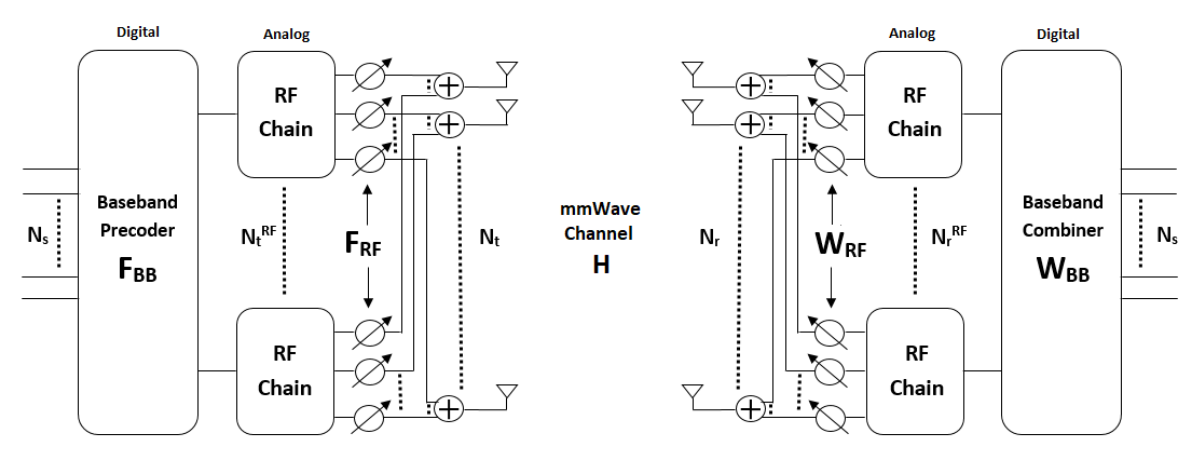
Fig. 4. mmWave Hybrid Beamforming